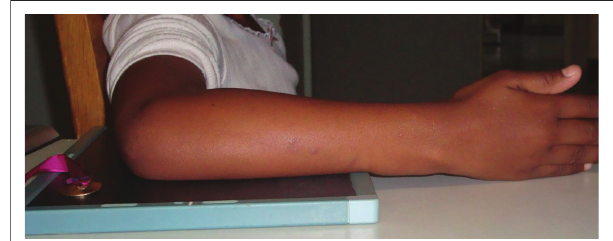
FIGURE 2: Positioning for the lateral projection. The elbow should be flexed at 90 degrees with the forearm supinated and thumb superior.